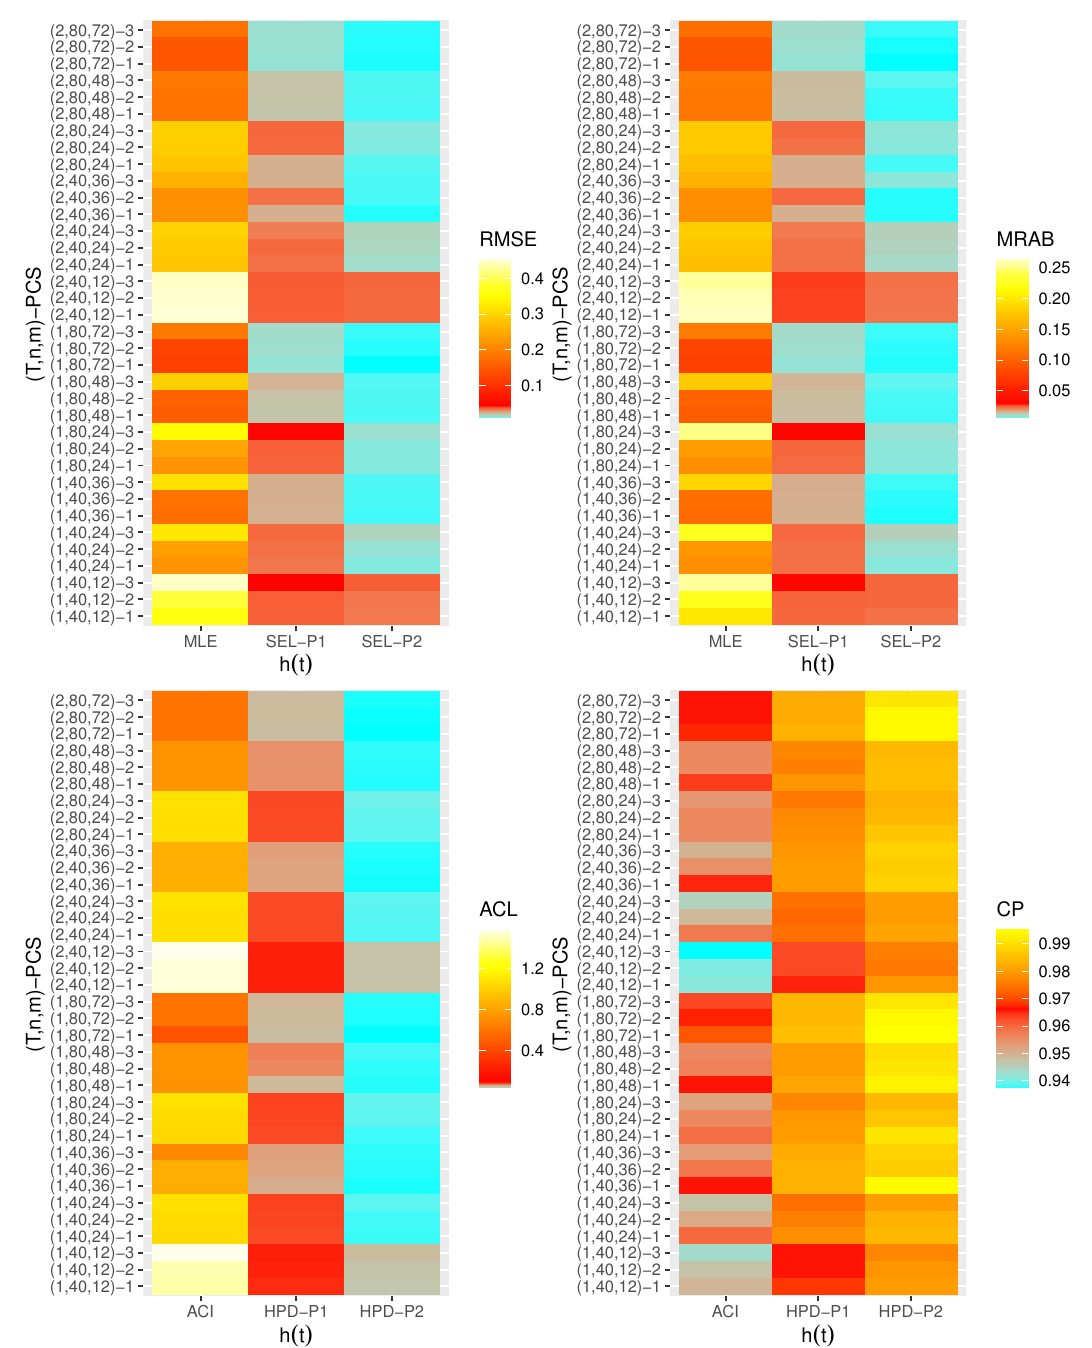
Figure 7. The heatmaps for the estimation results of h ( t ) when λ =